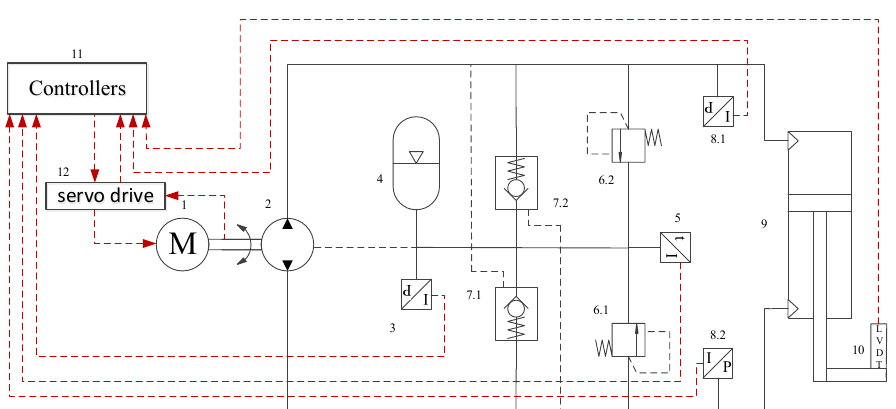
Figure 1. Schematic diagram of pump control system (PCS). 1: servomotor; 2: positive displacement pump; 3: low-pressure sensor; 4: accumulator; 5: temperature sensor; 6.1/6.2: relief valve; 7.1/7.2: pilot-operated check valve; 8.1/8.2: high-pressure sensor; 9: hydraulic cylinder; 10: displacement sensor; 11: controllers.